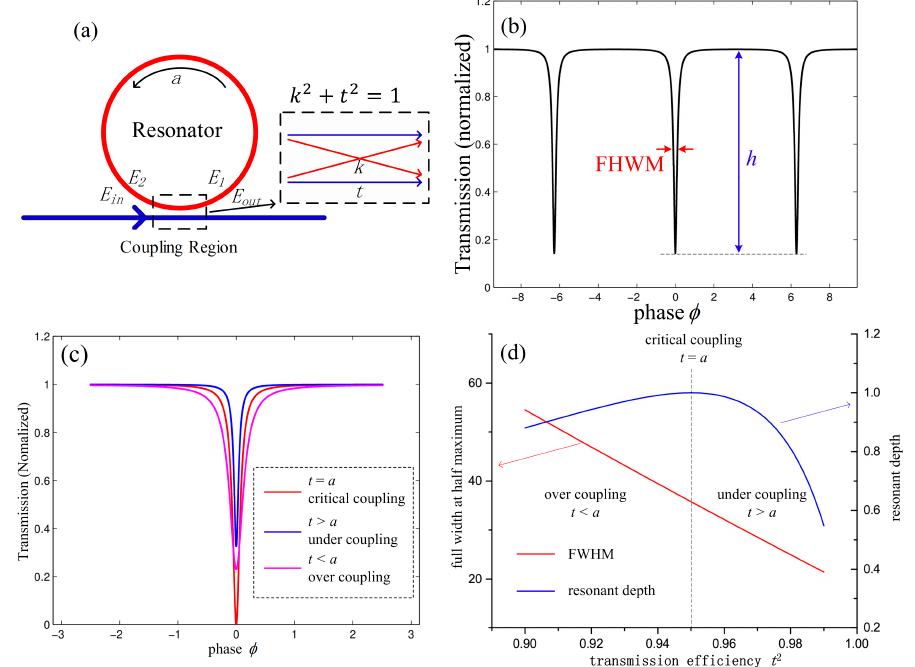
Figure 1. ( a ) Basic model of WGM resonator; ( b ) resonant spectrum of the resonator; ( c ) resonant spectra corresponding to critical coupling ( t = a ), under-coupling ( t > a ) and over-coupling ( t < a ); ( d ) full width at half maximum (FWHM) and resonant depth as functions of transmission efficiency a 2 = 0.95.